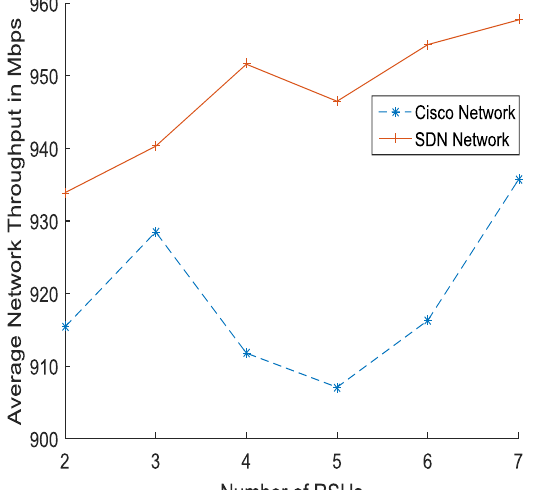
Figure 5. Average throughput of network